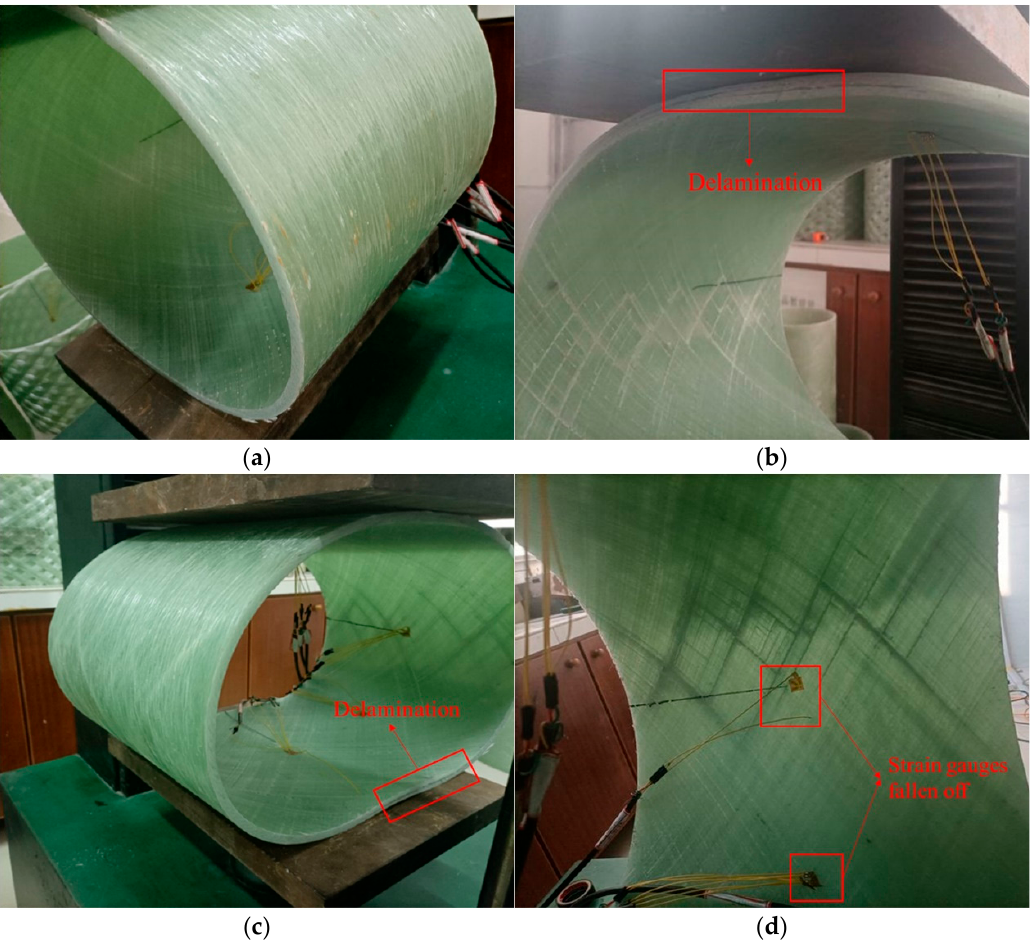
Figure 15. Deformation of plain pipes during failure phase: ( a ) 3% diametric deflection; ( b ) 15% diametric deflection; ( c ) 20% diametric deflection; ( d ) 30% diametric